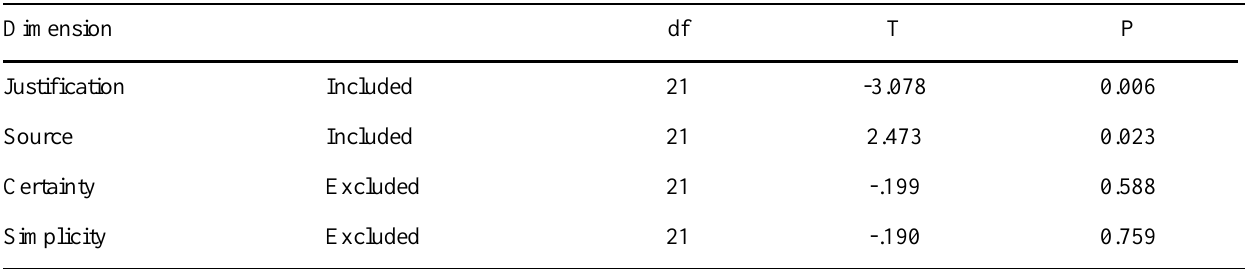
Table 10 . Final model (R 2 = 0.673) for forward stepwise multiple regression for the average post-test PEB scores for different dimensions in relation to academic